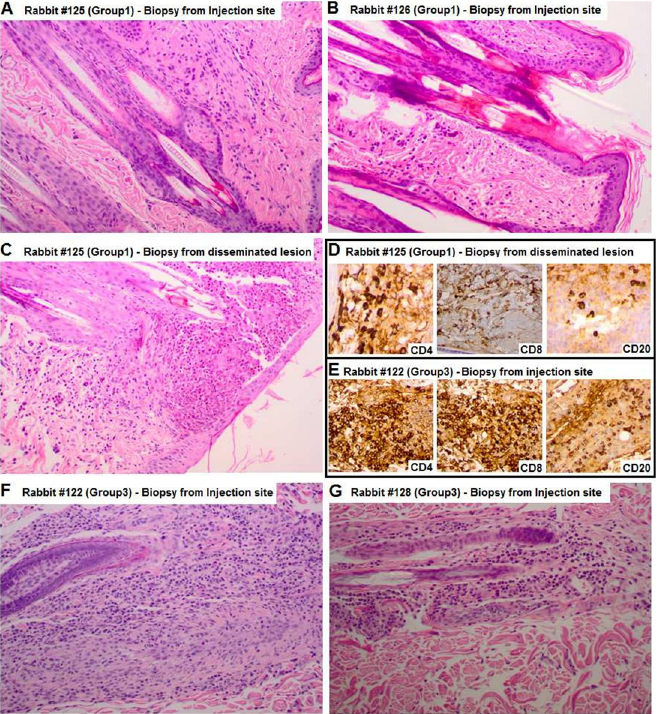
Fig 5. Histological analysis of lesion biopsies. Hematoxylin-Eosin. (A, B) Hematoxylin/eosin (HE) straining of biopsies obtained from Group 1 rabbits (#125 and #126, treated since day 4 post-inoculation). (C) HE staining of biopsy from a disseminated lesion of one of the Group 1 rabbits. (D, E) CD4/CD8/CD20 specific staining for the disseminated lesion biopsy of rabbit #125 (Group 1) and the injection site biopsy from control rabbit #122 (Group 3, treated since day 4 with carrier only). (F, G) HE staining of biopsies from lesion developed at the injection sites of Group 3 rabbits (#122, and #128), treated with carrier